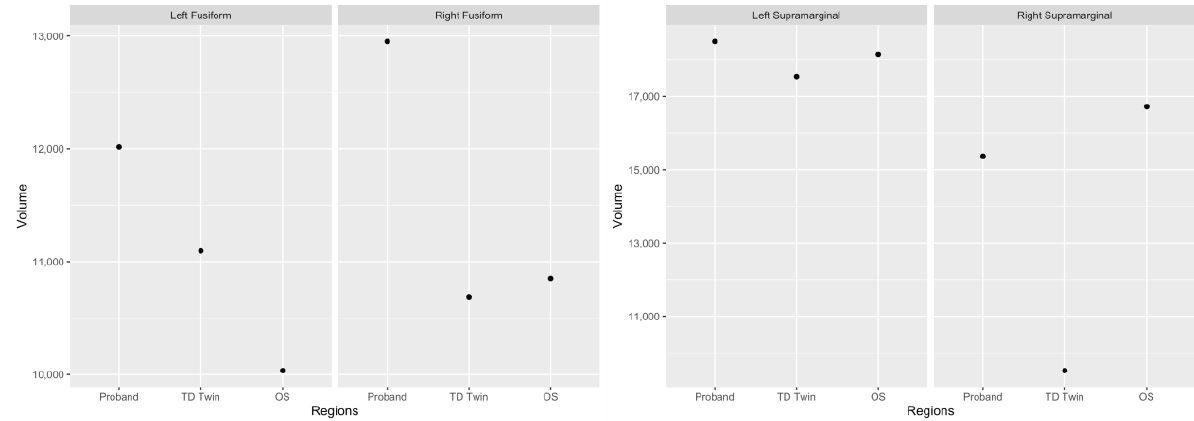
Figure 4. Plots of grey matter volume in the fusiform gyrus and supramarginal gyrus.